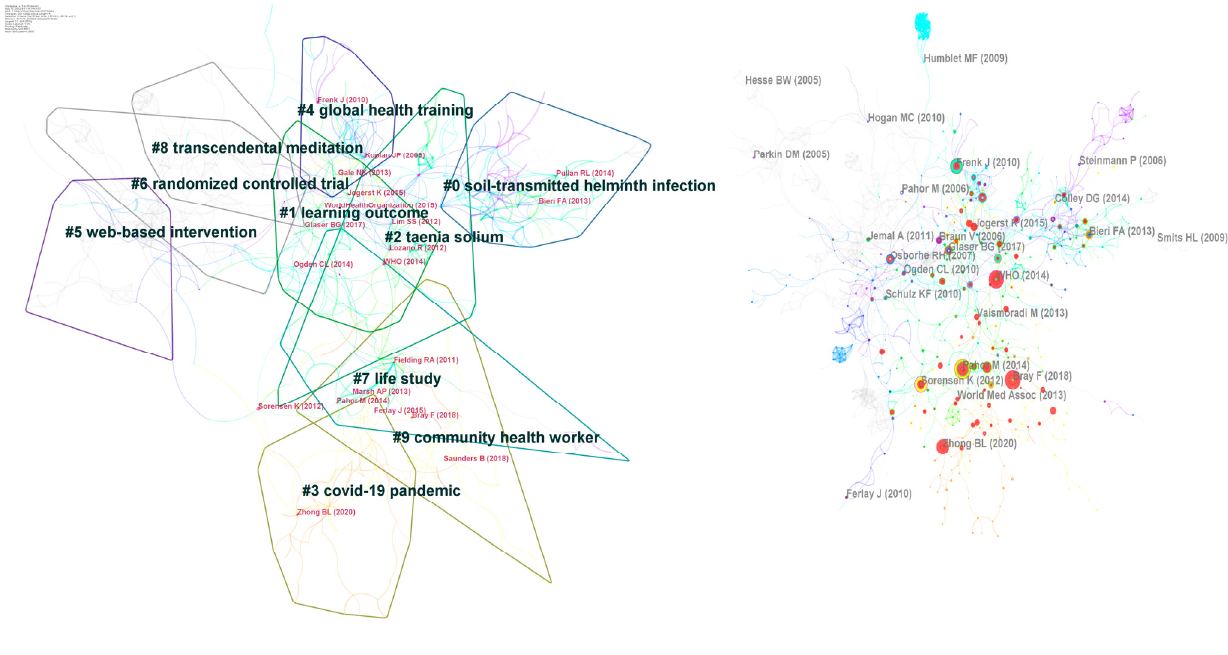
Figure 5. Document co ‐ citation analysis in HE research